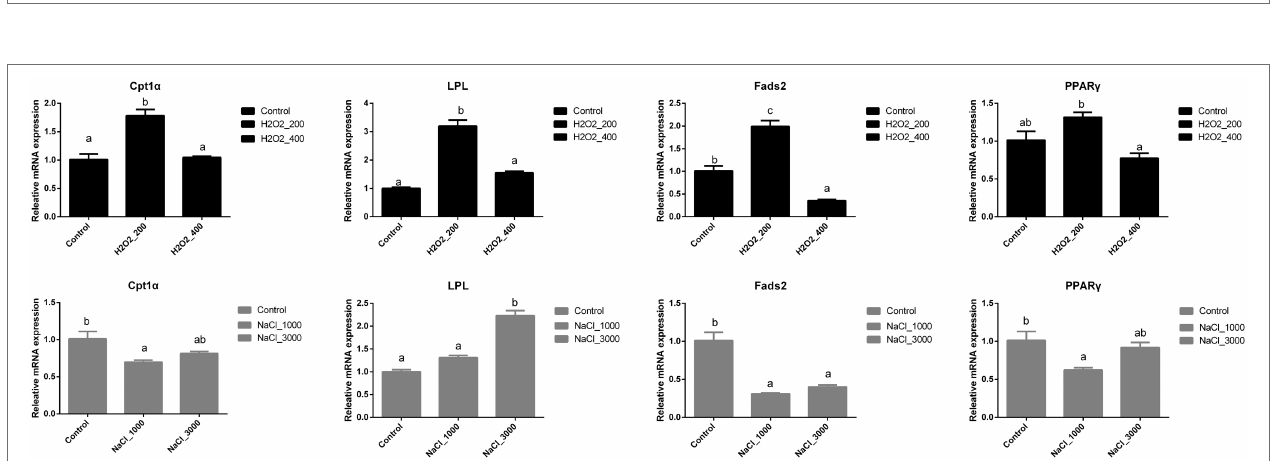
FIGURE 4 | Effects of H 2 O 2 (200, 400 mg/ml) and NaCl (1,000, 3,000 mg/ml) pre-treatment during egg hatching on the relative expression levels of genes involving immunity, including C1q, C3-1, C8b, MASP-1, IL15R α , and Hsp70 in loach larvae.